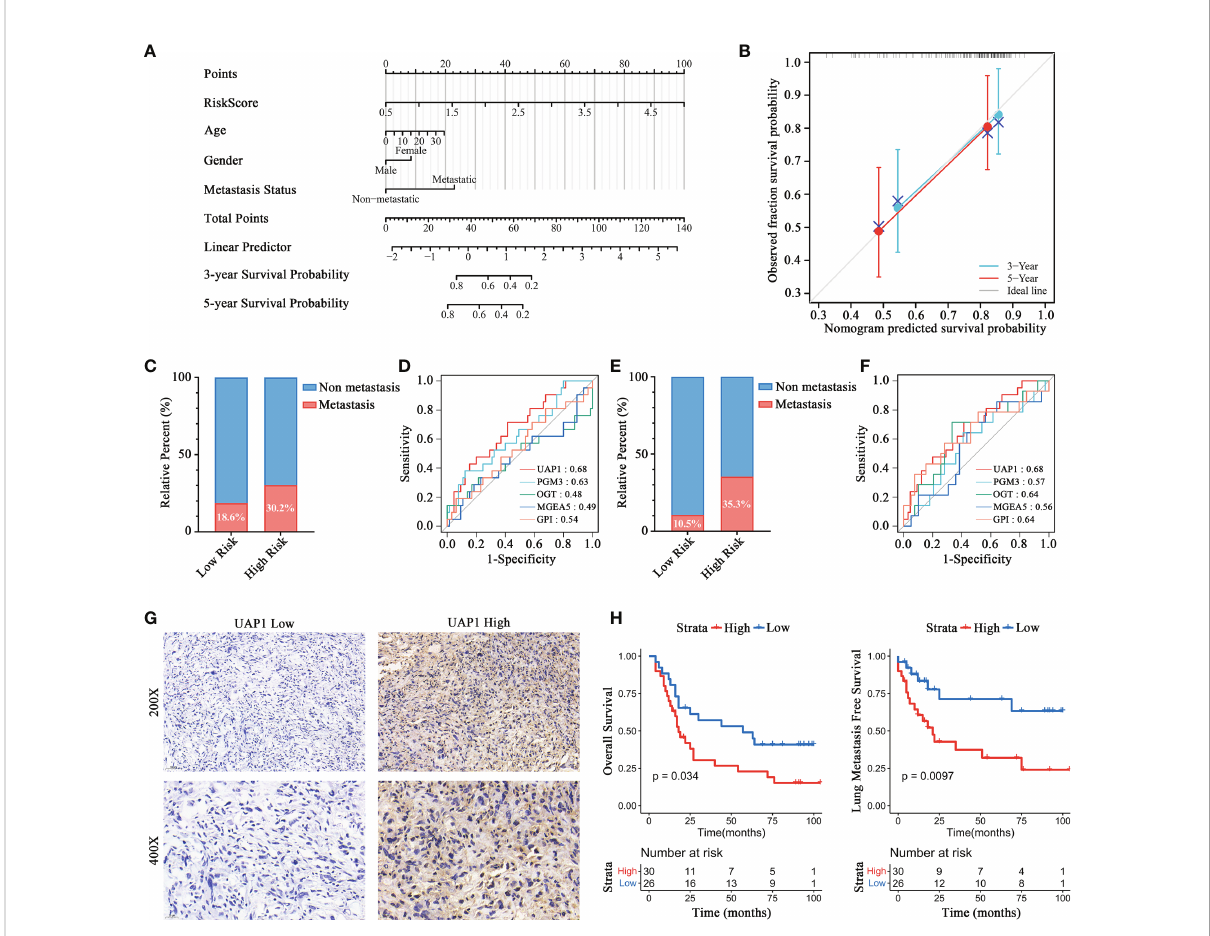
FIGURE 6 Prognosis prediction validation of HBP-related risk model for OS patients. (A) Nomogram for predicting the probability of 3-, and 5-year overall survival for OS patients. (B) Calibration plot of the nomogram for predicting the probability of overall survival at 3-, and 5 years. (C, E) Distributions of patients with metastasis and non-metastasis between high- and low-risk groups in Target-OS (C) and GSE21257 (E) cohorts. (D, F) ROC curves for evaluating the predictive ef fi cacy of HBP-related genes for metastasis in the Target-OS (D) and GSE21257 (F) cohorts. (G, H) Survival analysis showed a different survival portion between high and low UAP1 expression in osteosarcoma patients for overall survival (G) and lung metastasis free survival (H)